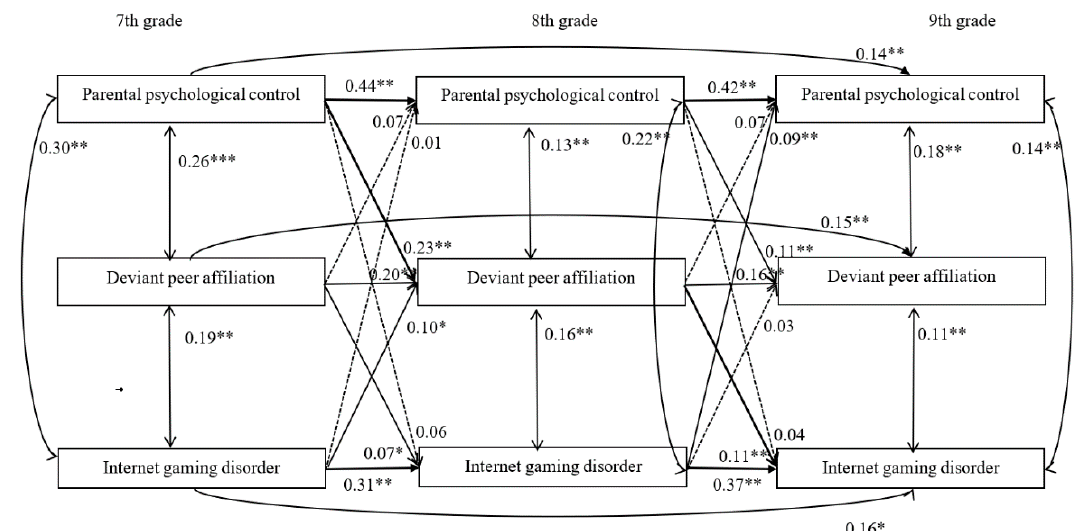
Figure 2. Model of the indirect role of deviant peer affiliation in the association between parental psychological control and Internet gaming disorder. Note: dotted lines indicate non-significant relationships. The path coefficients are standardized coefficients. * p < 0.05, ** p < 0.01.